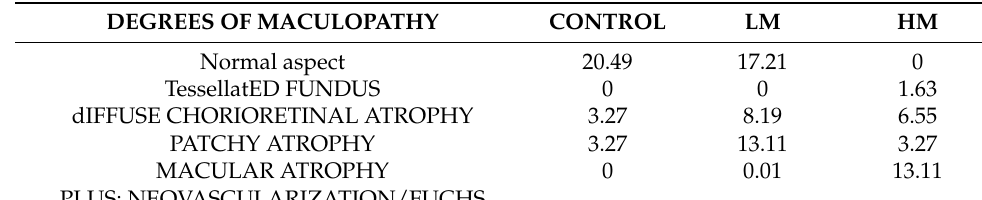
Table 2. Distribution of maculopathies in the eyes of the studied patients following IMI’s classification expressed as % of the entire study population.